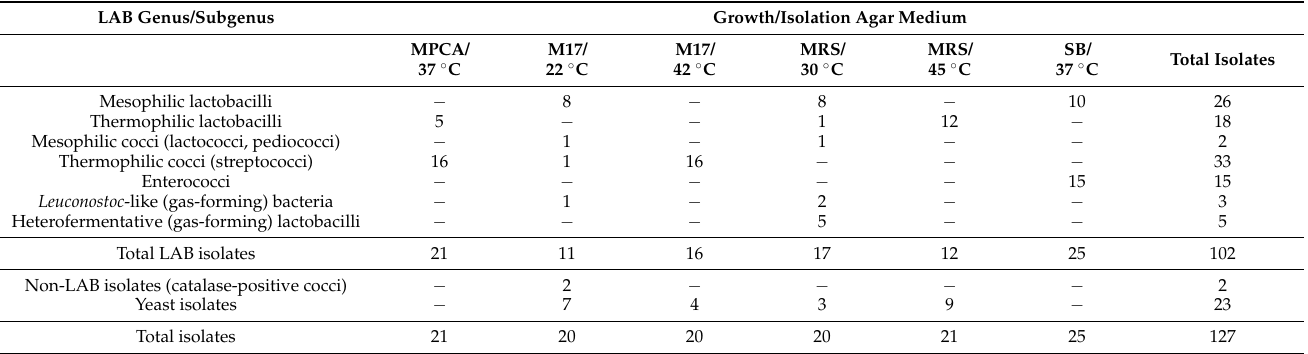
Table 4. Numerical distribution of the 102 LAB isolates and the remaining 25 non-LAB or yeast isolates from the four Galotyri PDO cheese batches in association with the selectivity of their enumer- ation/isolation agar